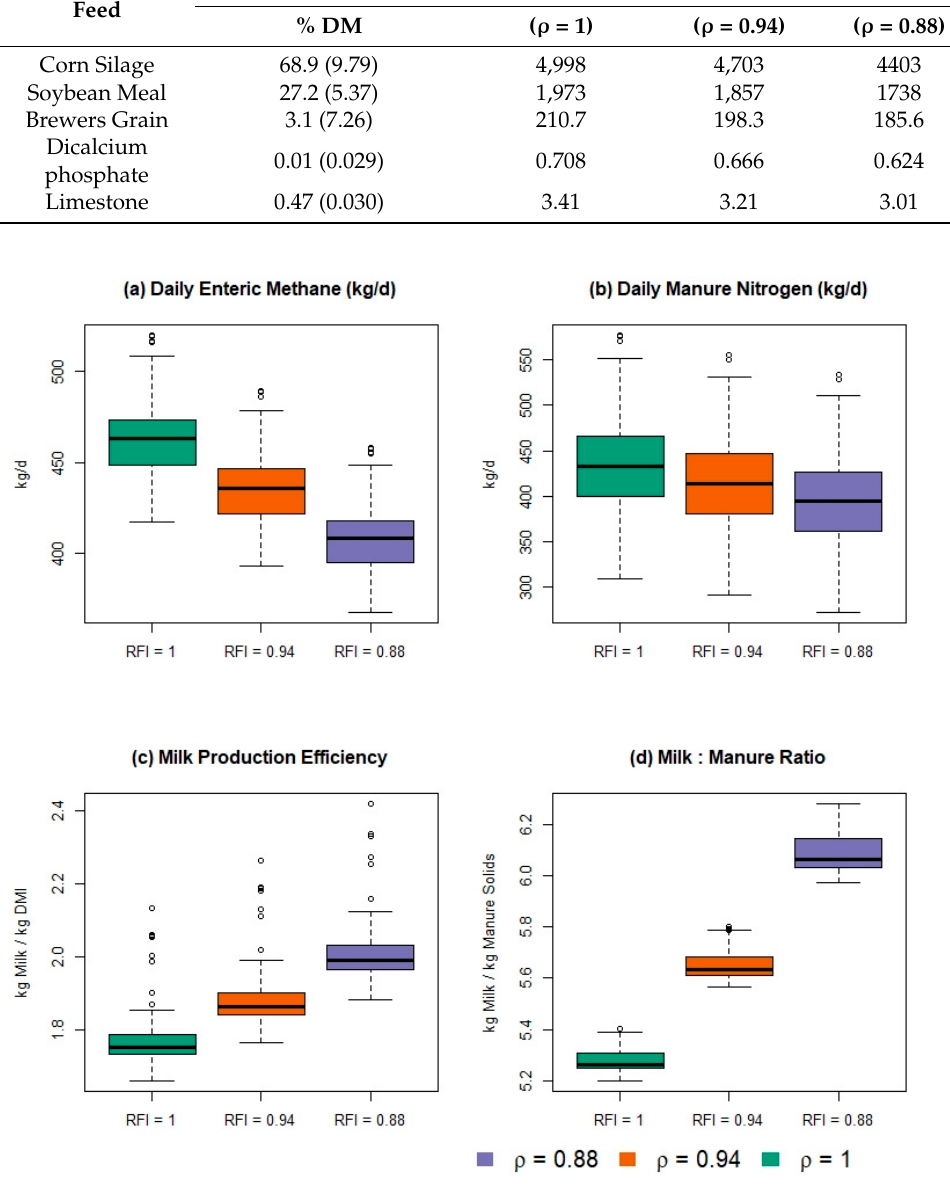
Figure 6. Boxplots of the distribution of daily expected ( a ) enteric methane, ( b ) manure nitrogen, ( c ) milk production efficiency, and ( d ) kg of milk production per kg of total manure solids from a 1000-cow herd of lactating Holstein cows simulated in the Ruminant Farm Systems Animal Module for 365 days with 3 levels of feed efficiency, as implemented by 3 different values of ρ , which is the proportion of expected feed intake consumed for a constant production